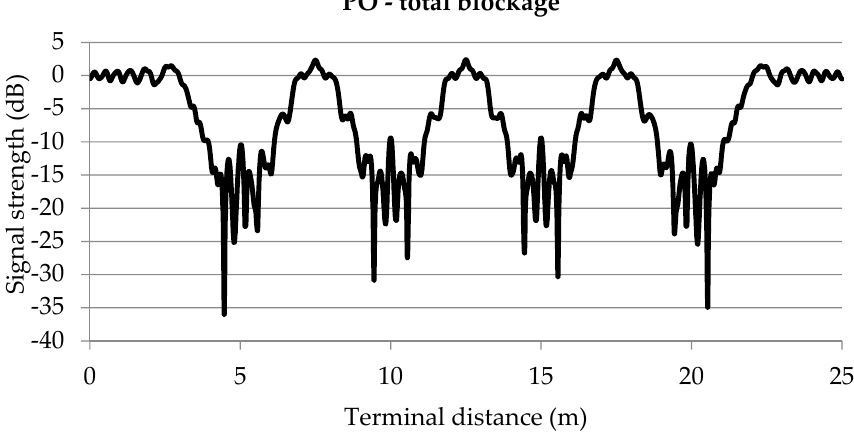
Figure 7. The coherent scattered field as obtained by PO in FEKO for the scenario from Figure 5 for the case of totally absorbing tree canopies.